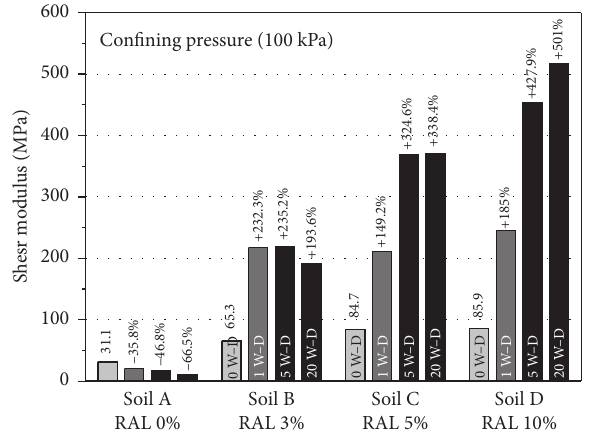
Figure 6: Shear moduli of the untreated and lime-stabilized specimens.